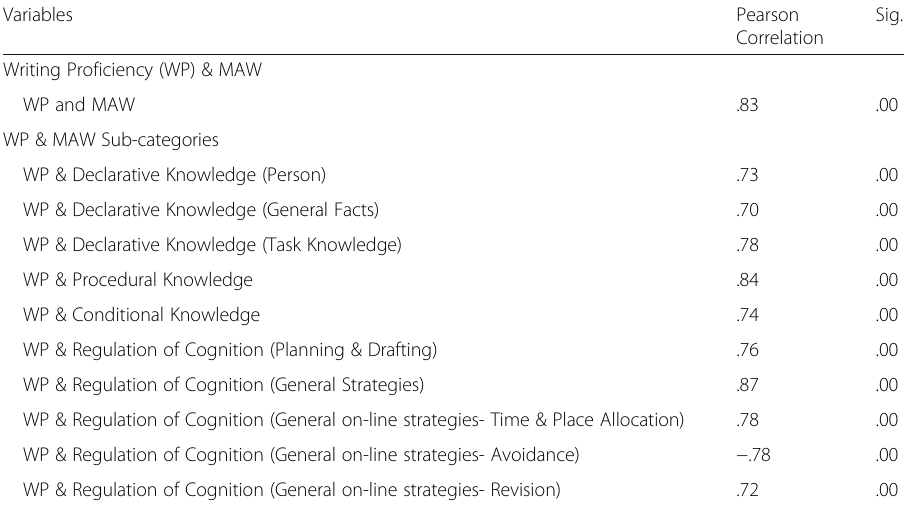
Table 6 Correlations between MAW (and its sub-categories) and writing proficiency Variables Pearson